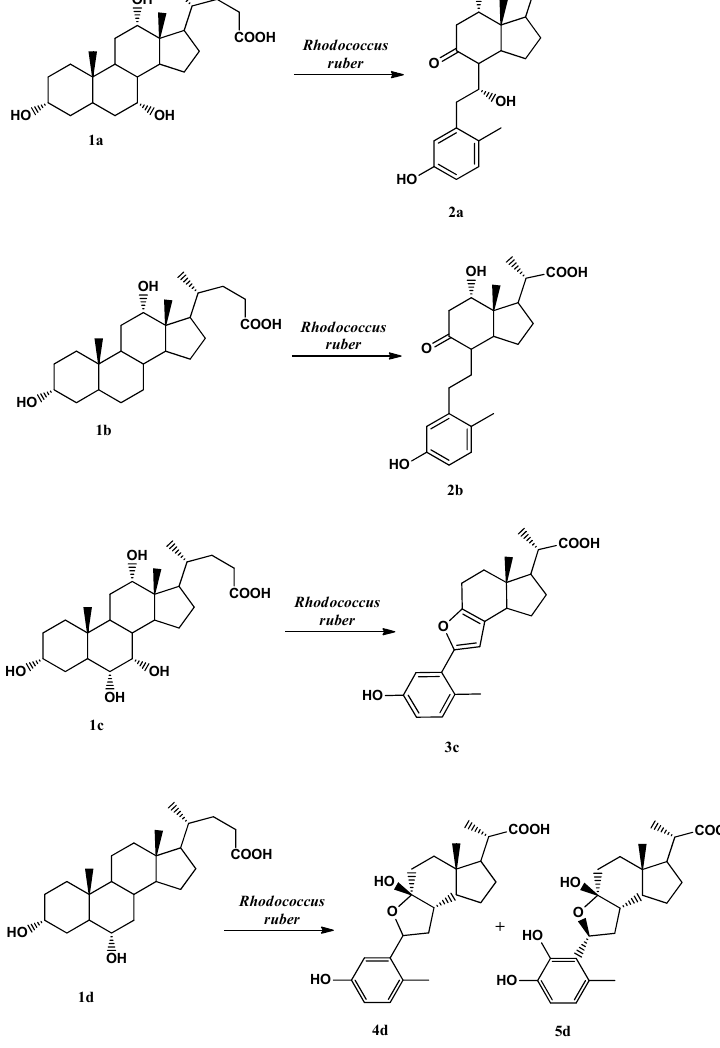
Figure 1. Bile acids and biotransformation products.